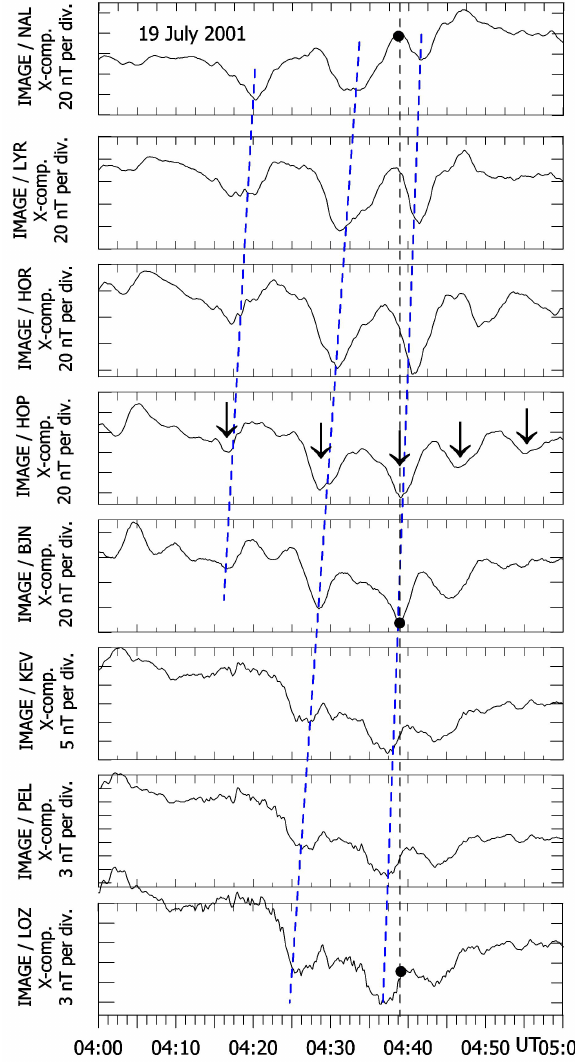
Fig. 13. Same format as in Fig. 3 for the event of day 200, 2001. In particular, we pay attention to the changes of phase observed at ∼ 04:38